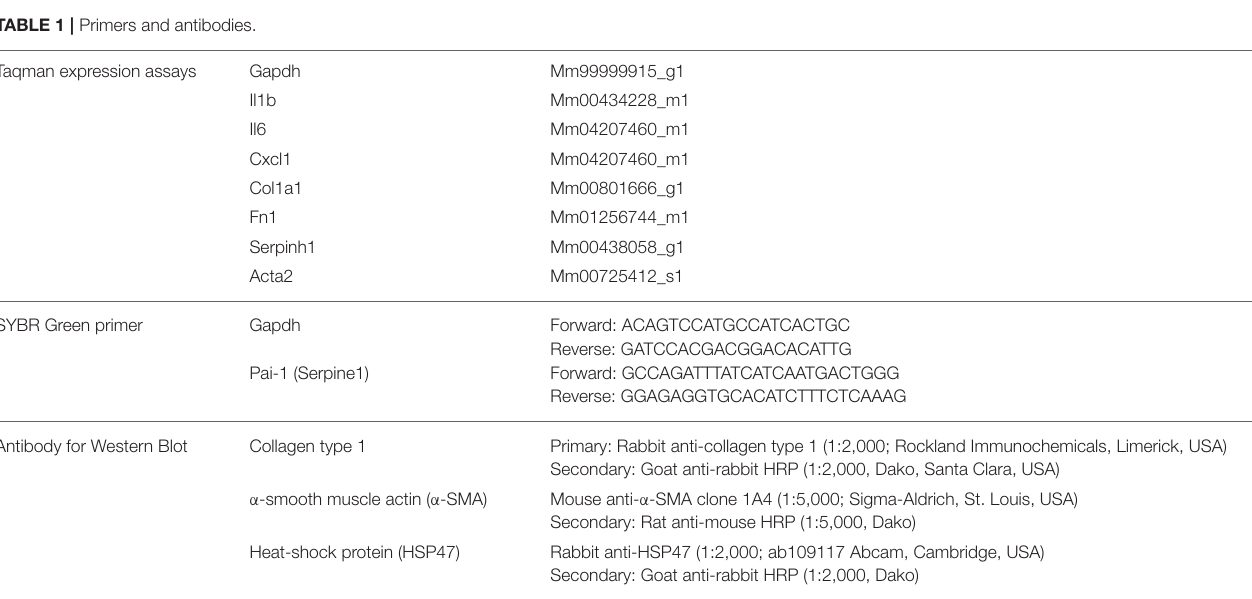
TABLE 1 | Primers and